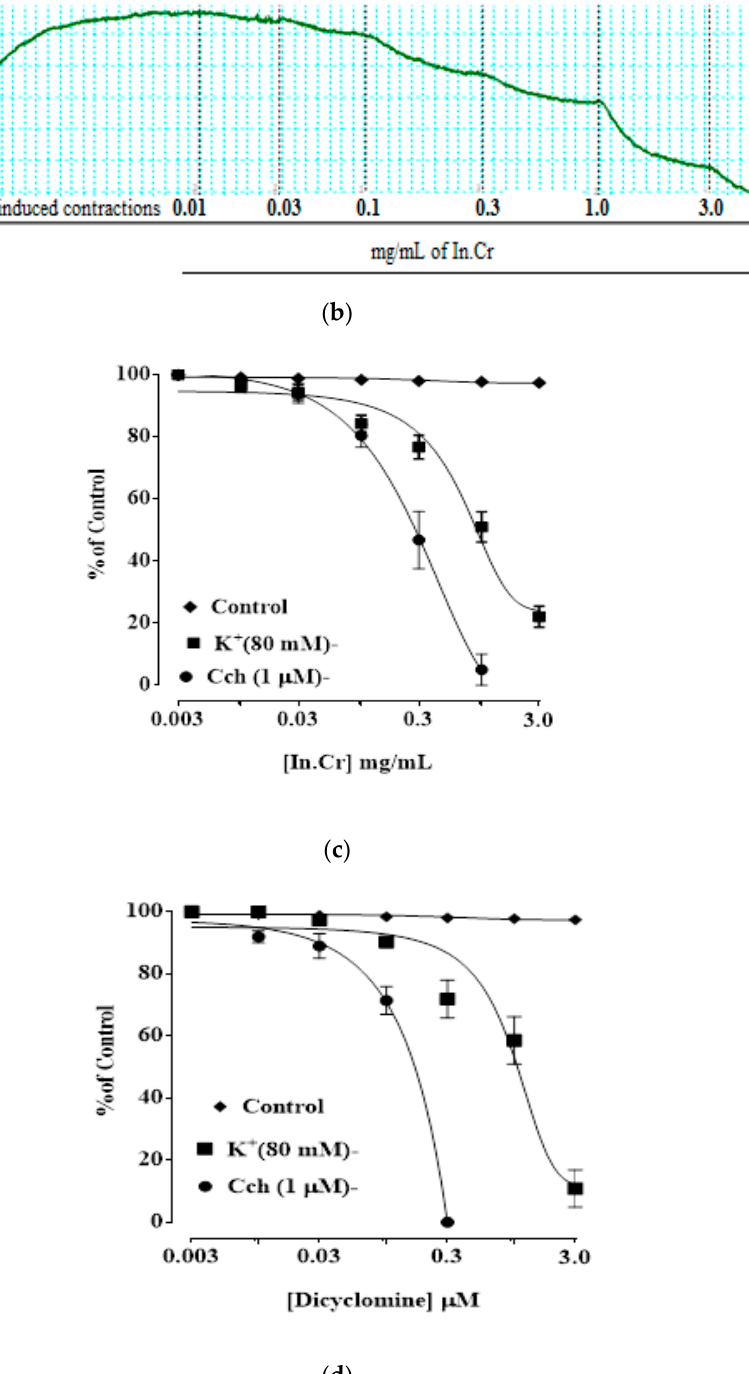
Figure 2. Dose dependent reduced effect ( a – c ) of In.Cr and ( d ) dicyclomine on Cch-induced slimming down on rabbit’s tracheal preparations. ( n = 5).